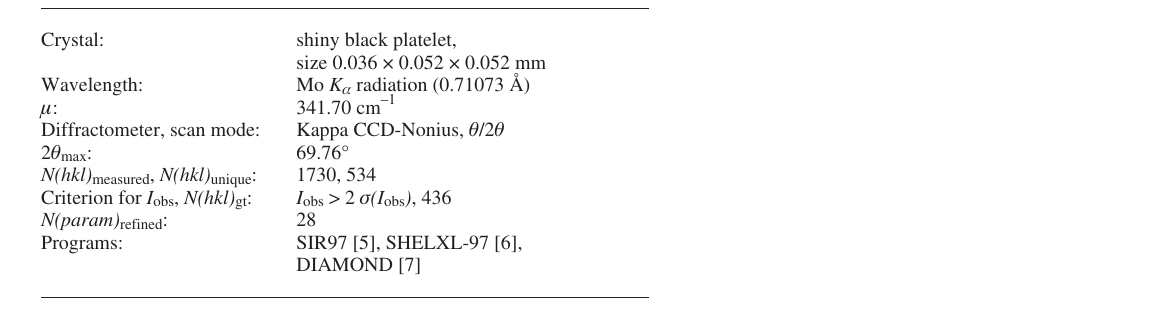
Table 1. Data collection and